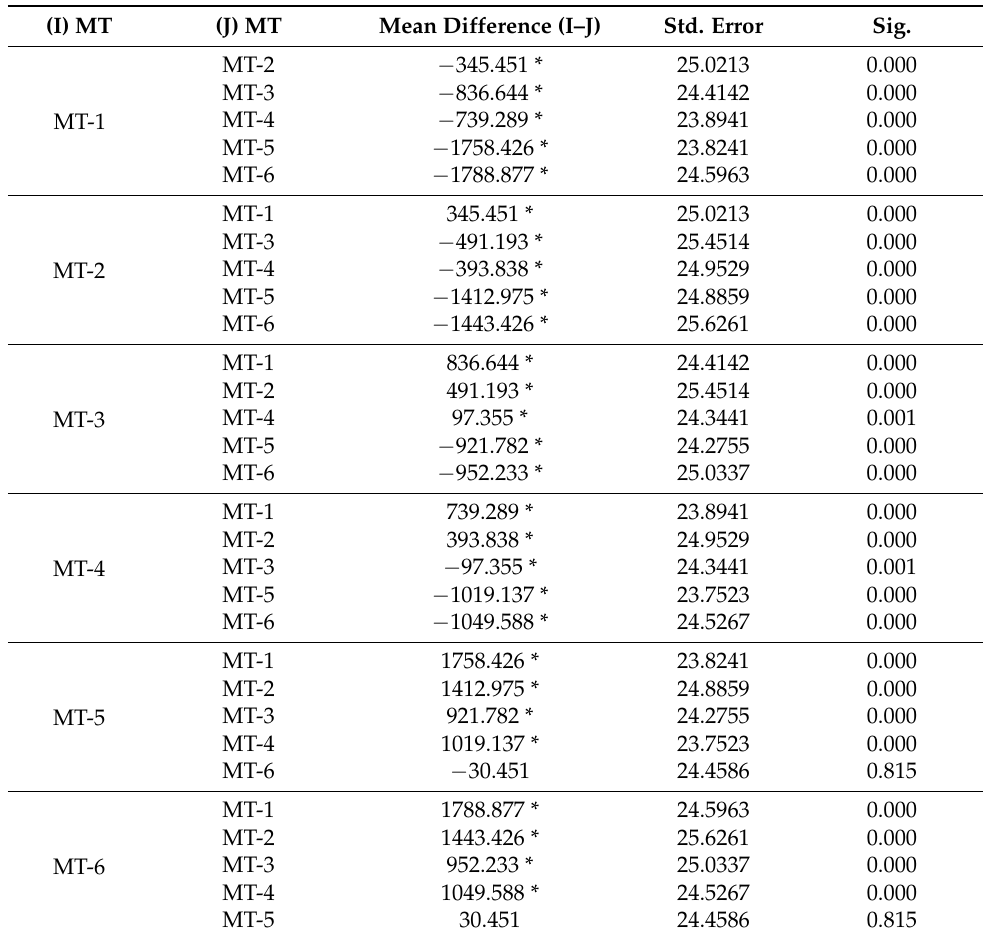
Table A1. iEMG value and Tukey HSD for MT.